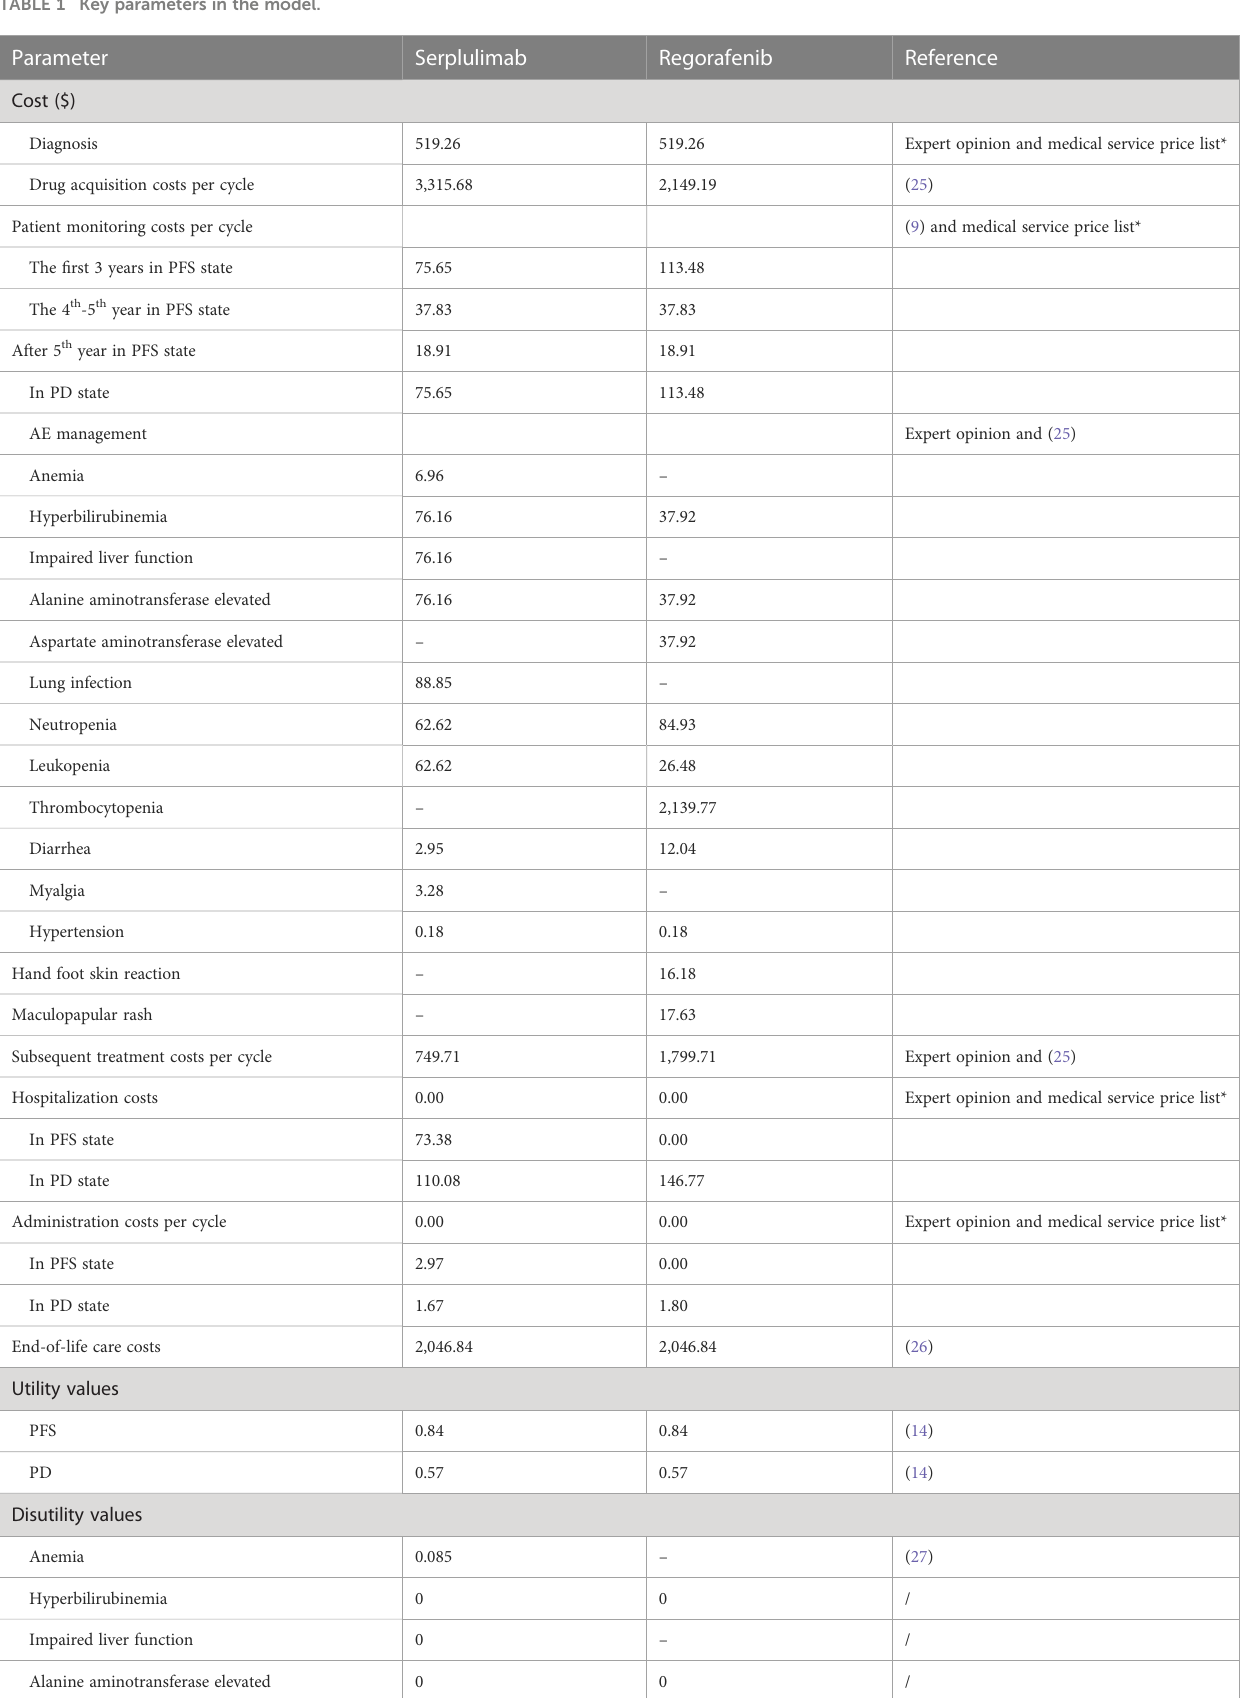
TABLE 1 Key parameters in the